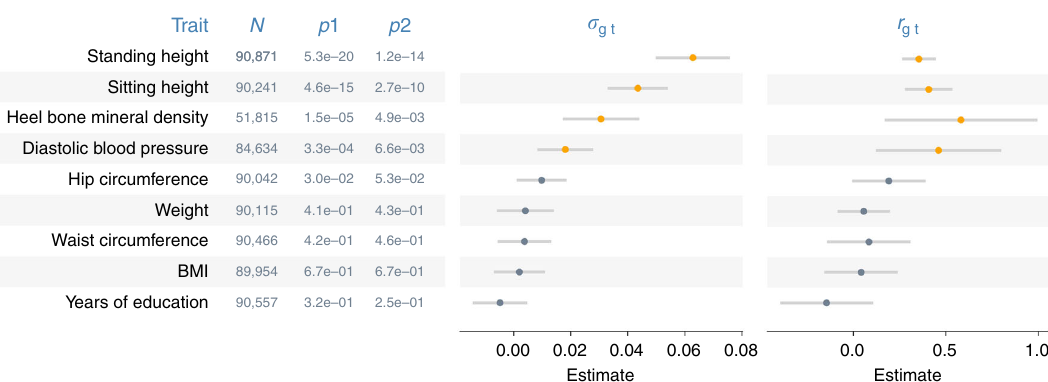
Fig. 4 Covariance estimates from genome-transcriptome partitioning analyses. Shown are estimated covariances ( σ gt ) and correlations ( r gt ) between the random effects of the genome and those of the imputed transcriptome. Error bars are 95% con fi dence intervals (based on s.e.m.). N = sample size; p 1 = p - values from likelihood ratio tests that compare GREML with CORE GREML to detect σ gt ; p 2 = p -values based on the Wald ’ s test statistic under the null hypothesis that r gt = 0 (i.e., a two-sided test). Highlighted in orange are signi fi cant σ gt and r gt after a Bonferroni adjustment for multiple comparisons. Fluid intelligence is excluded because the effects of the imputed transcriptome on this trait was not signi fi cant after Bonferroni correction. Source data are provided as a Source Data fi le.